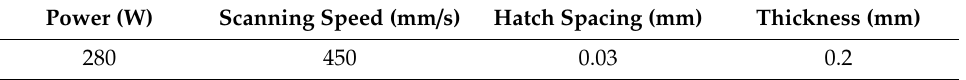
Table 1. Process parameters of V-SLM (vacuum selective laser melting).